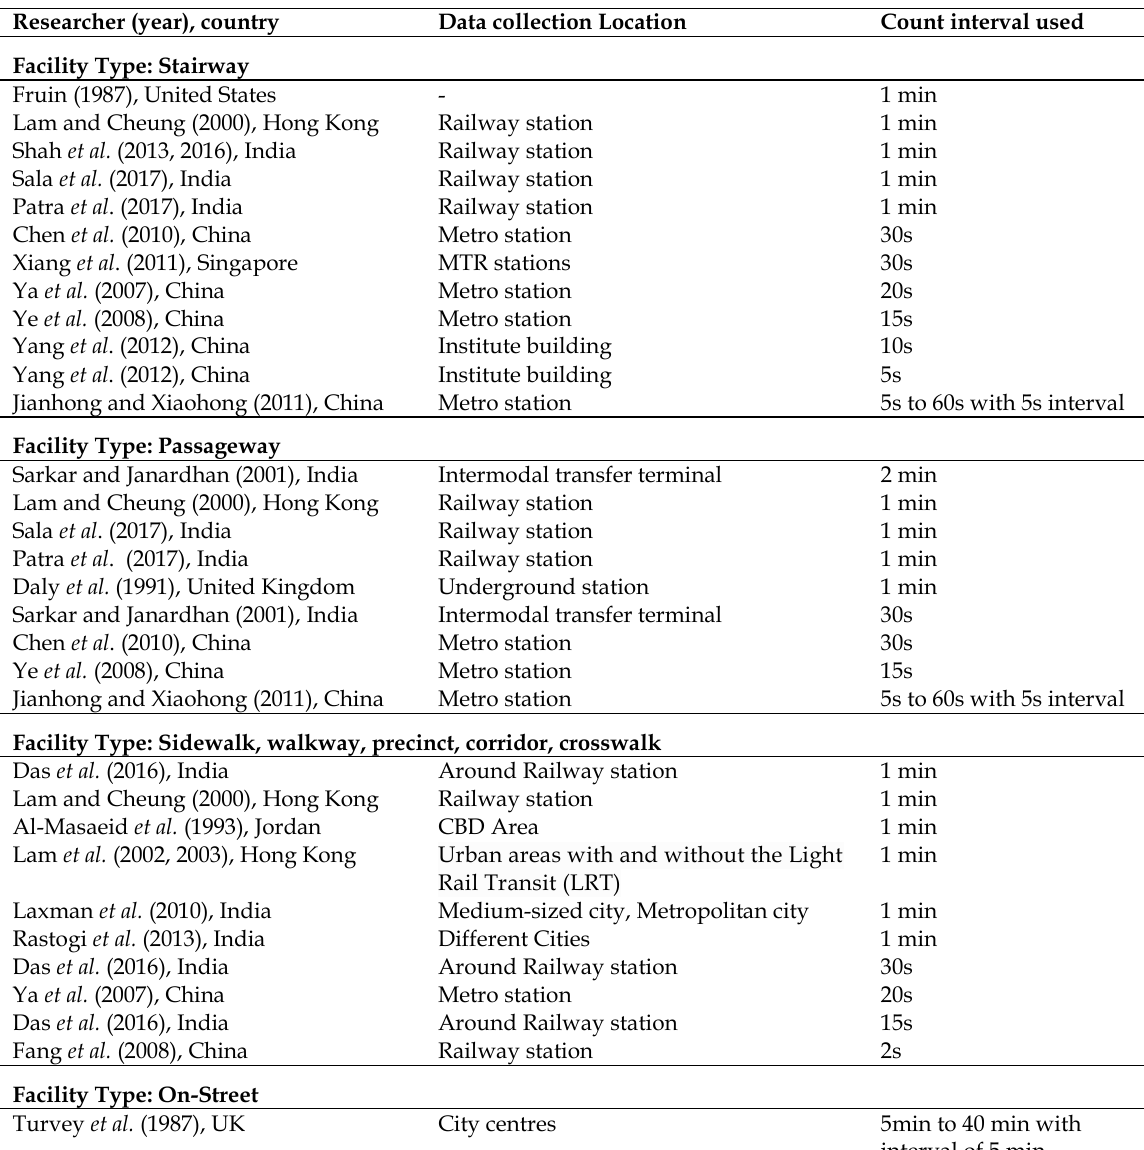
Table 1. Data Extraction Count Interval used in Different